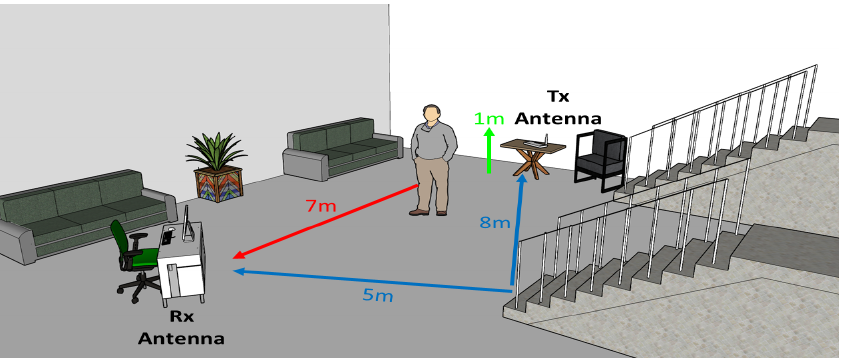
Figure 2. Test scenario for fall detection experiments and positioning of the measurement